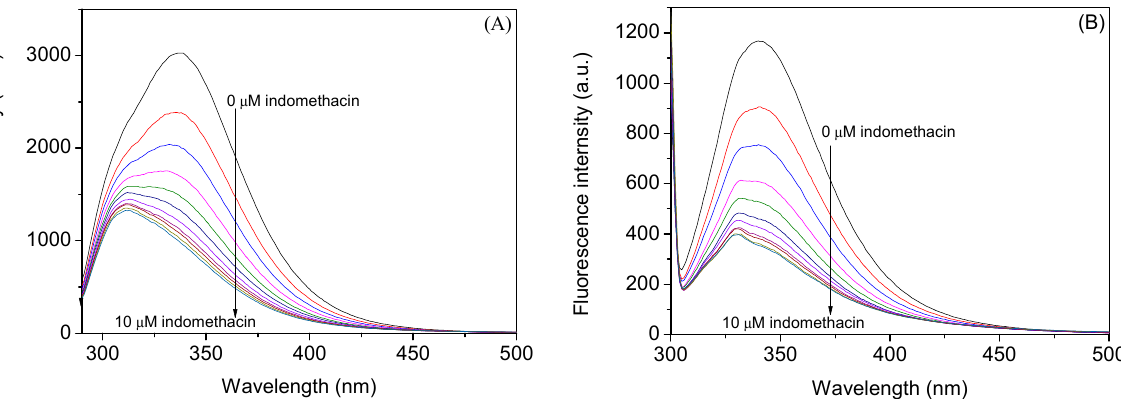
Figure 3. Observed fluorescence spectra of HSA in the absence and presence of indomethacin at λ ex of 280 nm ( A ) and 295 nm ( B ) at 25 °C. [HSA] = 3 µM and [indomethacin] = 0 (black) 1.0, 2.0, 3.0, 4.0, 5.0, 6.0, 7.0, 8.0, 9.0, and 10.0 µM.